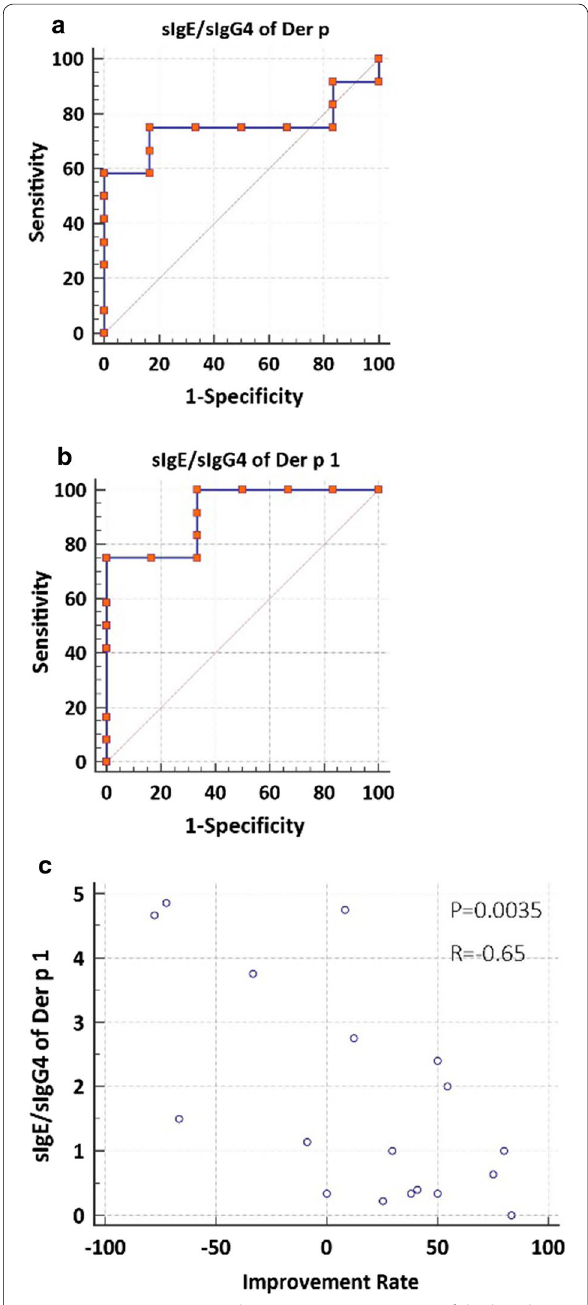
Fig. 2 Receiver operating characteristic (ROC) curve of the baseline sIgE/sIgG4 ratio of Der p ( a ) and Der p 1 ( b ) as predictive parameters of clinical responsiveness, and the correlation between baseline sIgE/sIgG4 ratio for Der p 1 and clinical improvement rate for TCS at 52-weeks of AIT ( c ). AIT, allergen